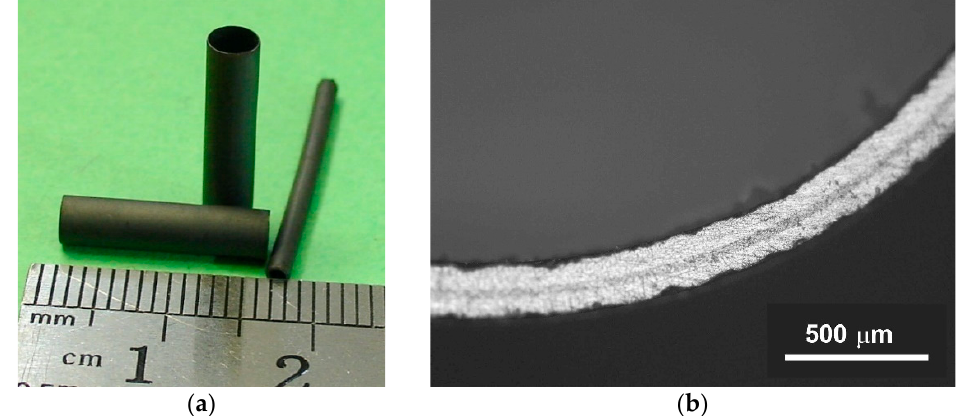
Figure 9. Microtubular oxygen pumps samples: ( a ) appearance and ( b ) microphotographs of the